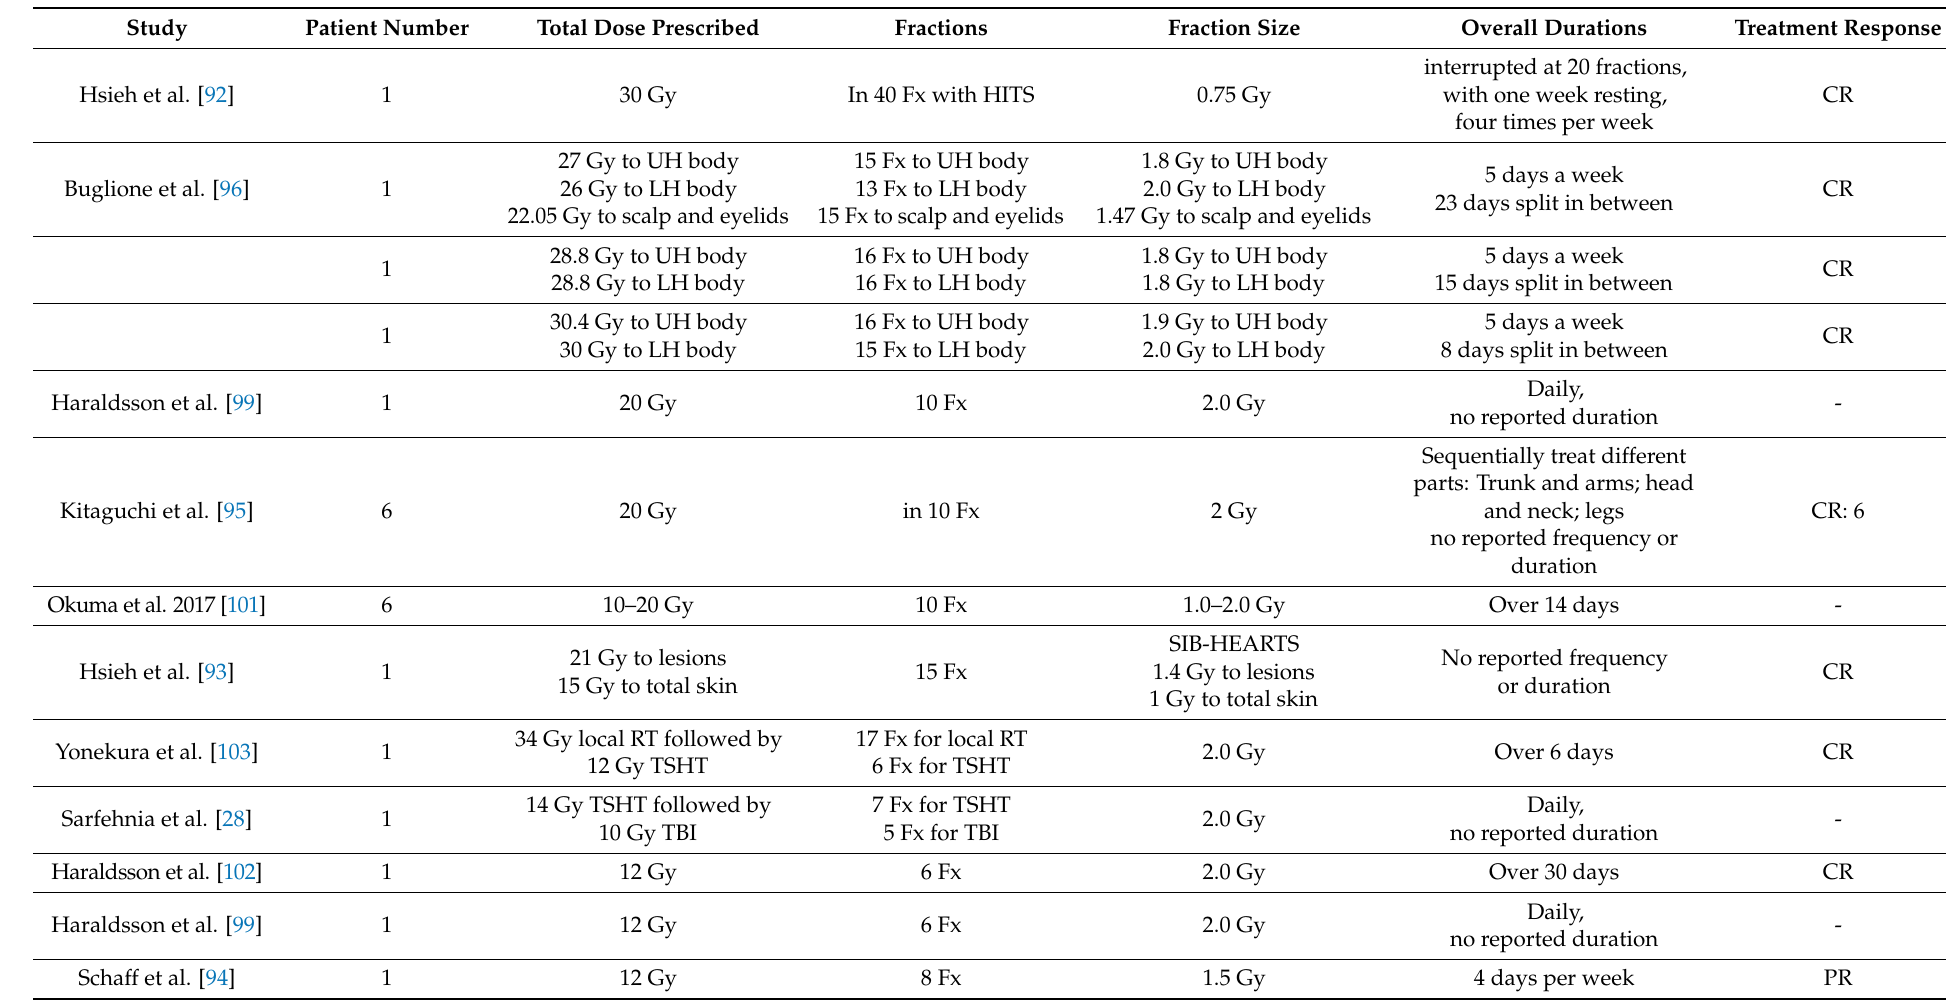
Table 1. The reported dose regimens and treatment response of total skin helical